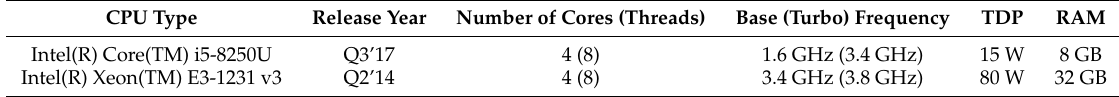
Table 2. The computer architectures [12,13] used to measure run